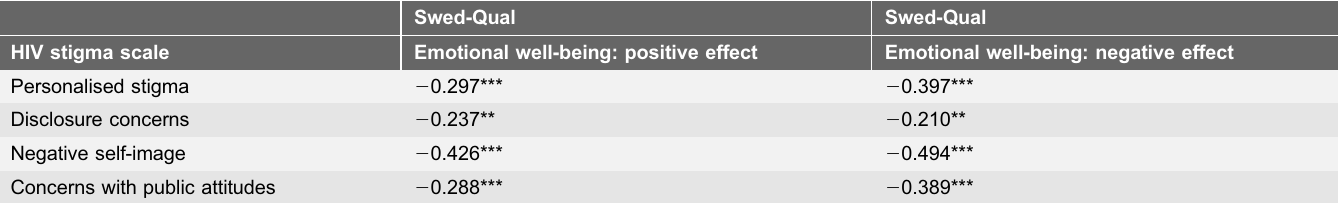
Table 5. Bivariate correlations a of the HIV stigma scale subscales and selected Swed-Qual subscales.